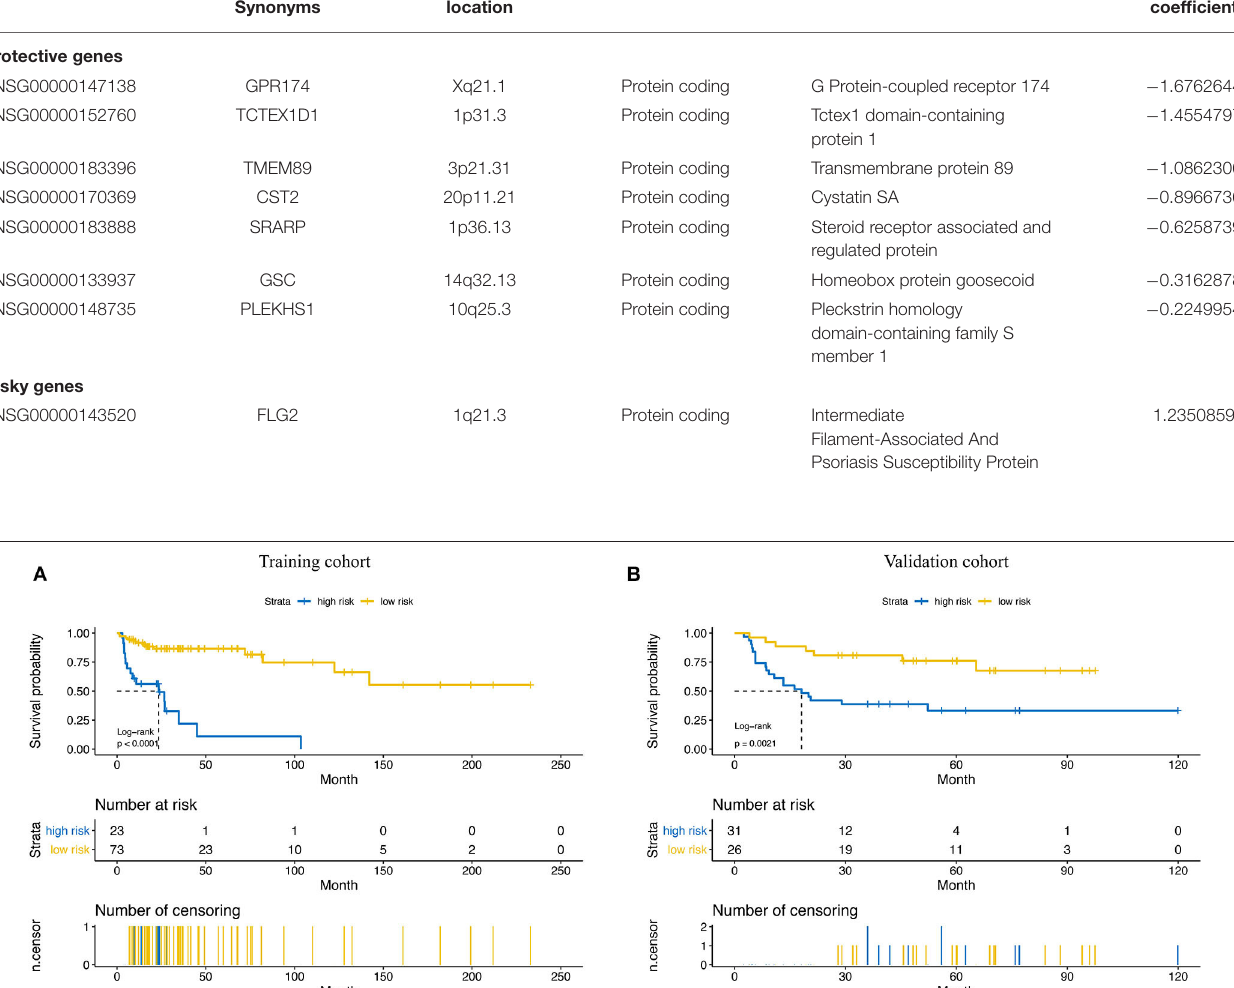
Frontiers in Oncology |